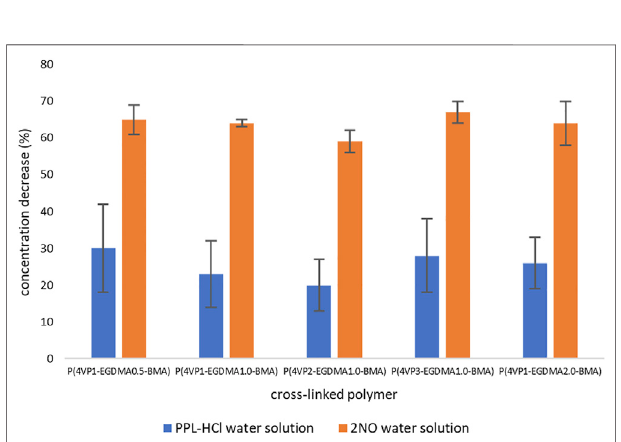
Frontiers in Chemistry |